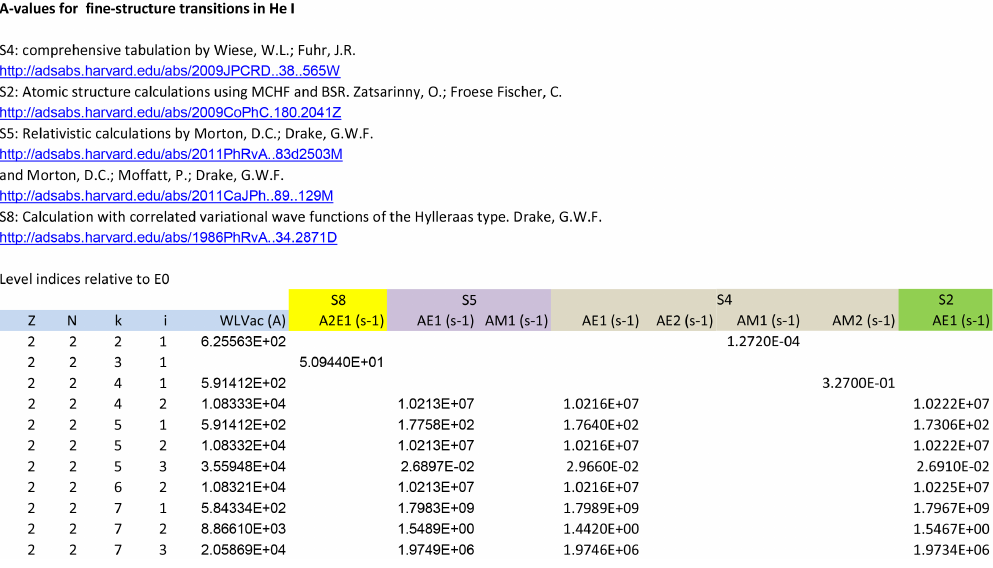
Figure 6. Workbook 02_02 for He I showing the 02_02.A0 worksheet with A -values for transitions with upper level k ≤